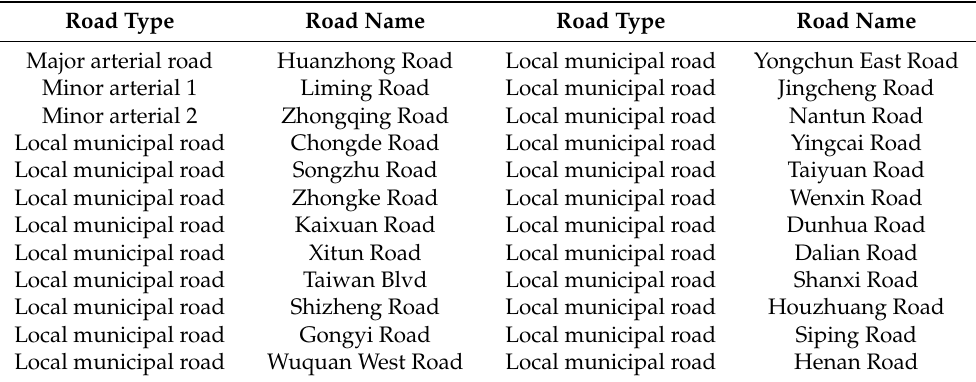
Table 2. The 24 different road sections used in the